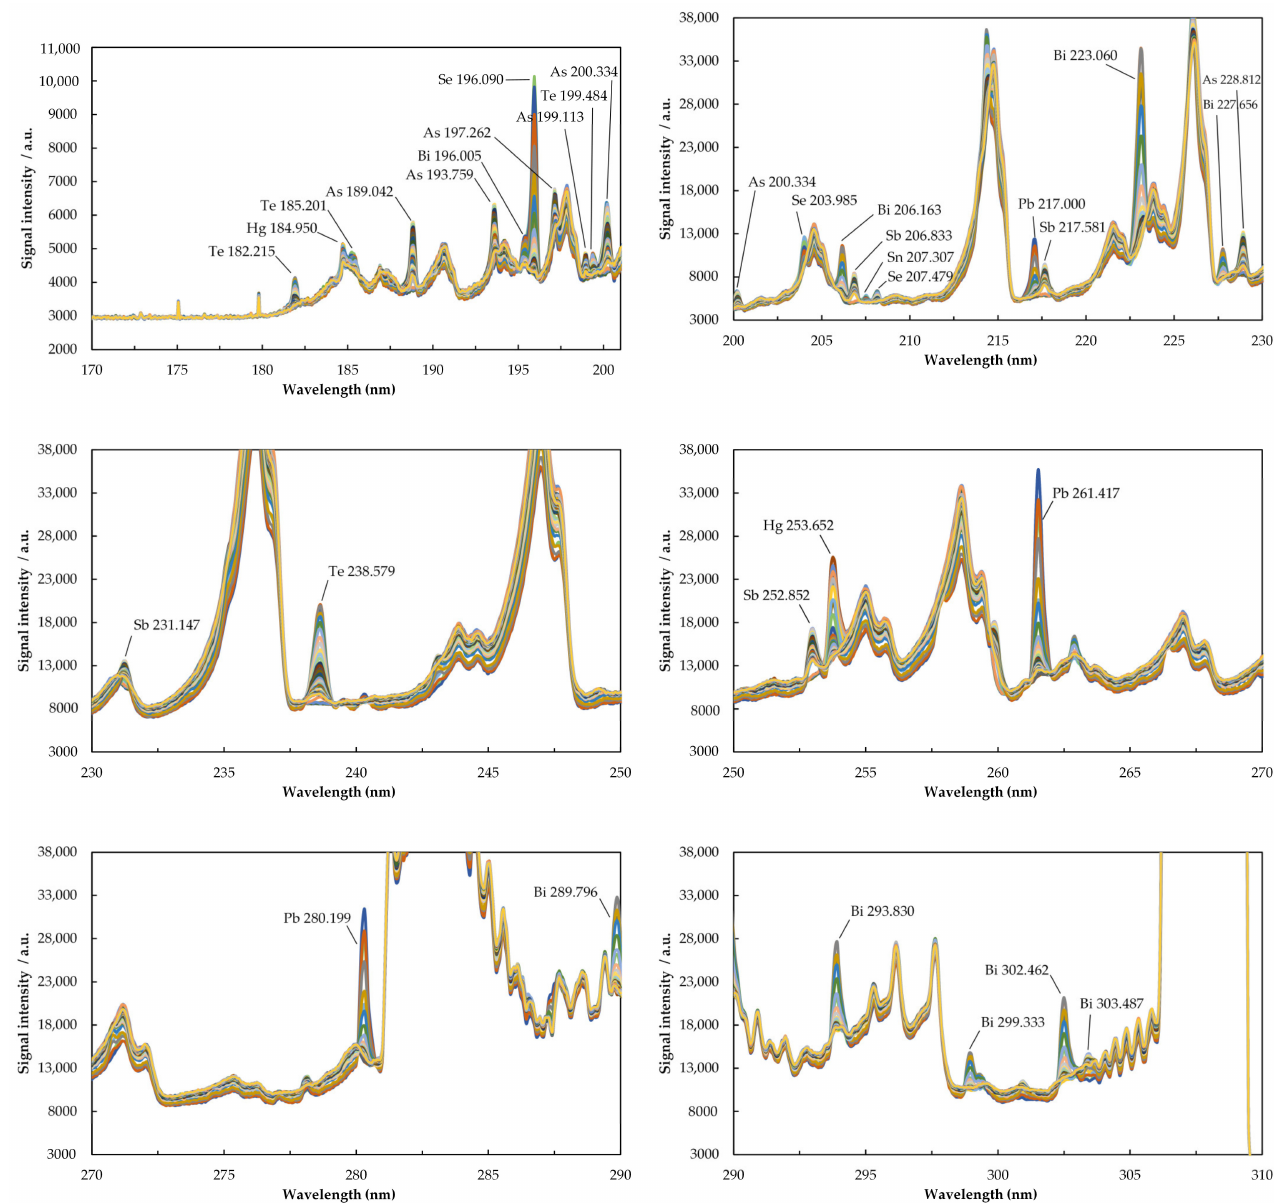
Figure 1. Episodic emission spectra of As, Bi, Sb, Se, Te, Hg, Pb, and Sn in SSETV- µ CCP-OES recorded with the Ocean Optics Maya2000 Pro microspectrometer in High Speed Acquisition mode. Conditions: 10 µ L sample volume containing 3 µ g mL − 1 As, Bi, Se, Te, and Sn; 1 µ g mL − 1 Pb and Sb; and 0.2 µ g mL − 1 Hg; drying temperature: 80 ◦ C for 180 s; electrothermal vaporization temperature: 1300 ◦ C for 10 s; integration time per episode: 200 ms; plasma power: 15 W; Ar flow rate: 150 mL min − 1 ; observation height: 0.8 mm above the electrode